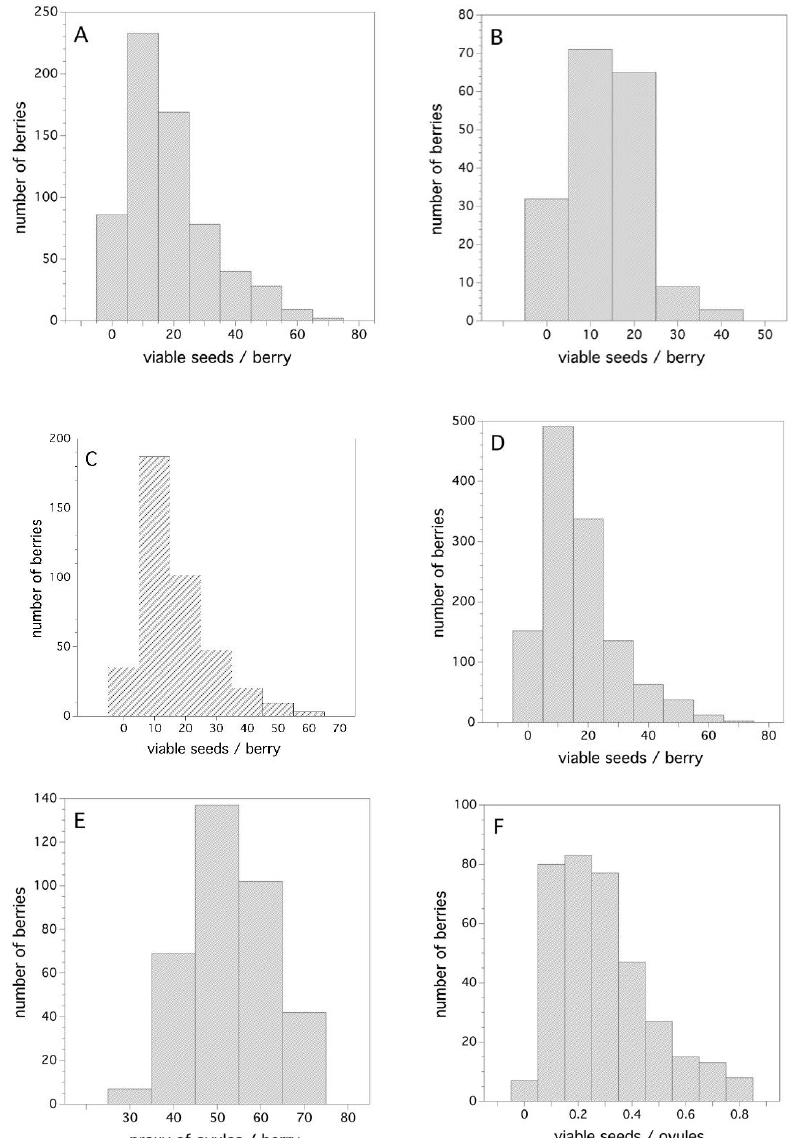
Figure 6. Frequency distributions for viable seeds, ovules, and the ratio of viable seeds per number of ovules/berry, ( A ) 2006, ( B ) 2007, ( C ) 2011, ( D ) all years, ( E ) 2011 ovules/berry, and ( F ) 2011 ratio of viable seeds/ovules/berry.